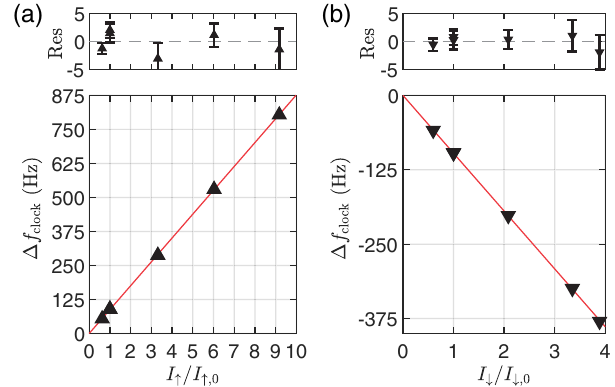
FIG. 3. Clock shifts at the operational Raman detuning as a function of (a) the upleg laser intensity, and (b) the downleg laser intensity. The horizontal axes are normalized by the respective operational intensities, I ↑ and I ↓ . Solid lines are linear fits to ; 0 ; 0 the data. Residuals are plotted in units of Hz. Error bars represent 1 σ